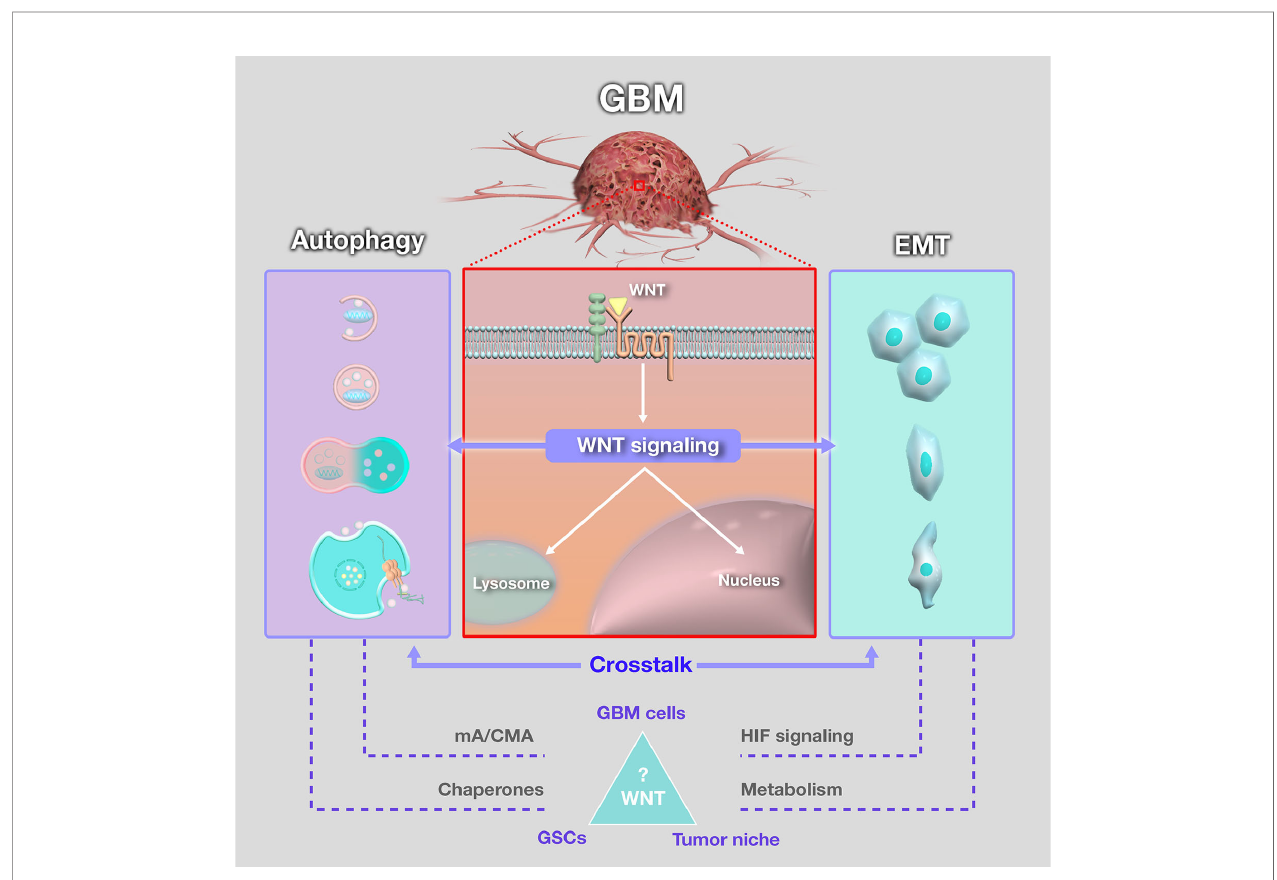
FIGURE 3 | Schematic summary of the crosstalk between WNT signaling, autophagy and epithelial-mesenchymal transition (EMT) in glioblastoma (GBM). Despite the extensively discussed relevance, the importante of WNT pathways in the crosstalk between autophagy and EMT in GBM is still surrounded by open questions. Among them, the role of microautophagy (mA) and chaperone-mediated autophagy (CMA) is largely unknown. Moreover, function of chaperones in this context might represent a target for crosstalk regulation in GBM, in glioblastoma stem-like cells (GSCs), tumor bulk and tumor niche, and warrant further investigation. Accordingly, the role of HIF signaling and metabolic reprogramming on this crosstalk should also be a subject for future research